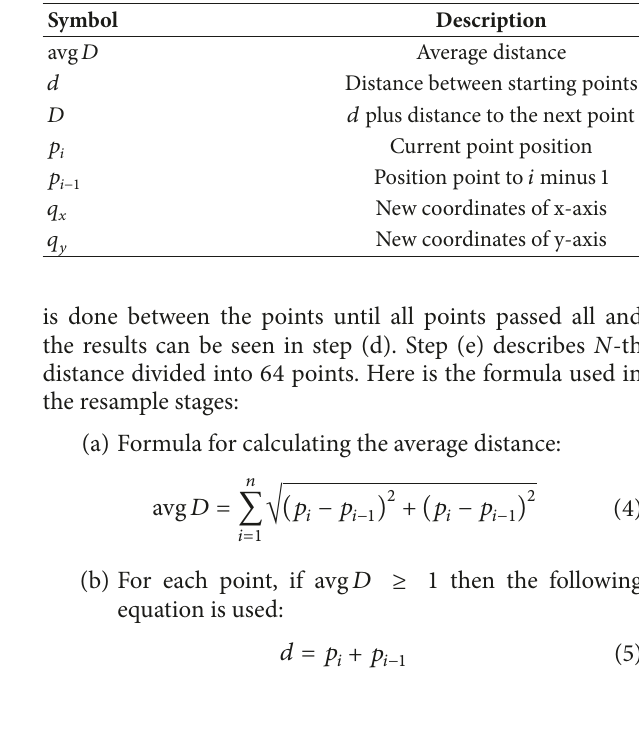
Table 5: Description of Formula